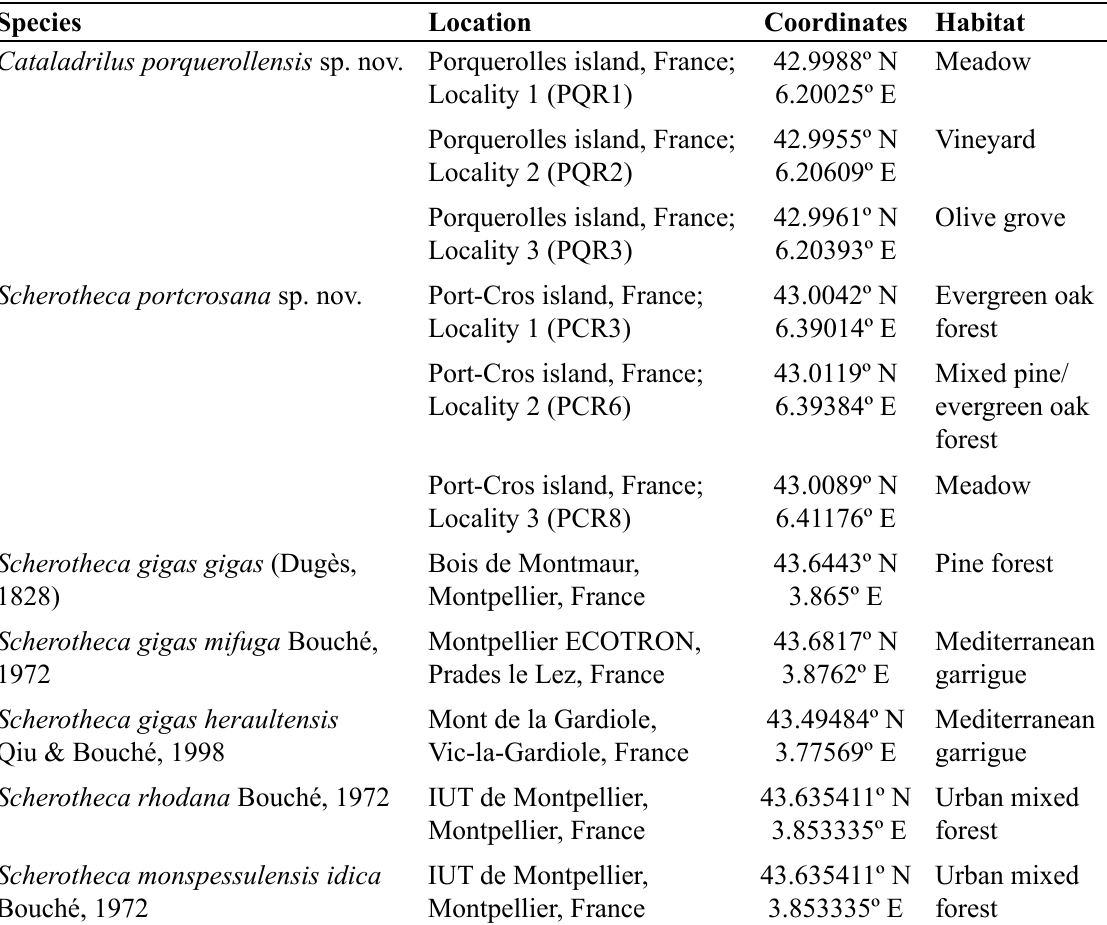
Table 1. List of species studied in this work and their sampling localities.